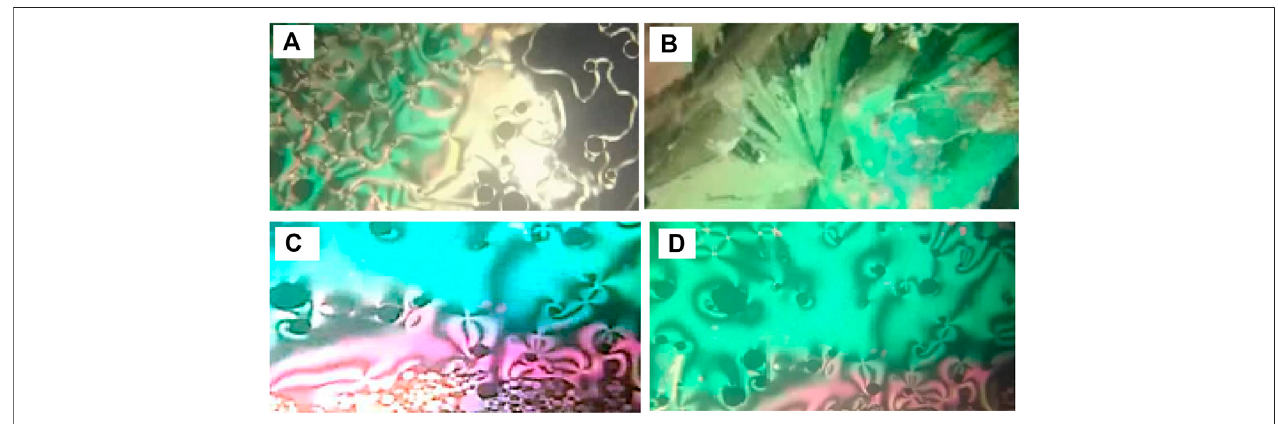
FIGURE2| ImagesdetectedbyPOMfor (A) derivative F 12 ofNphase at105.0 ° Conheating; (B) derivative F 12 ofSmAphase at 84.0 ° Con cooling; (C) derivative F 6 of N phase at 135.0 ° C on heating; (D) derivative F 10 of N phase at 120.0 ° C on heating.